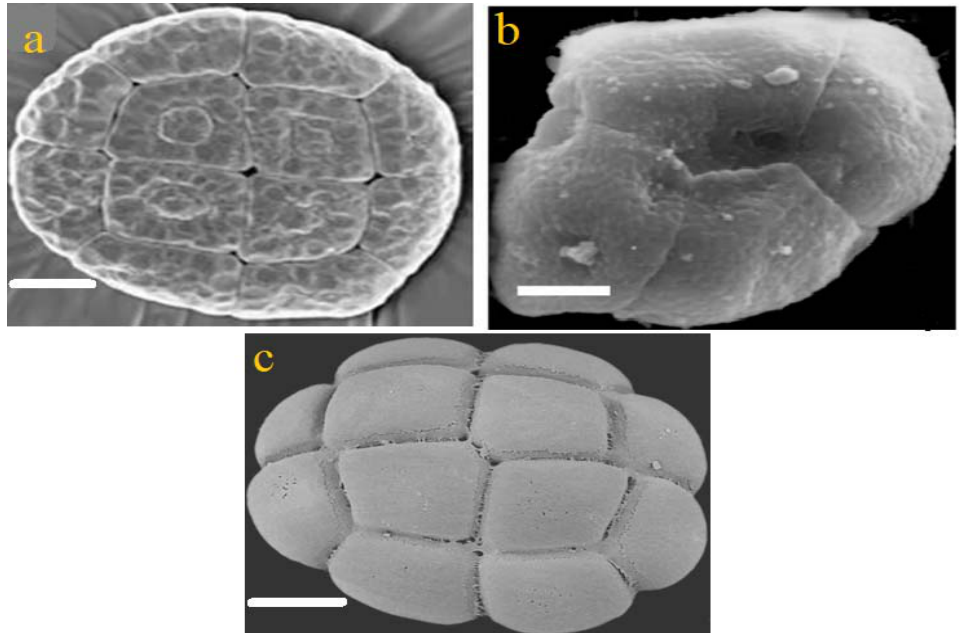
Figure 4. SEM micrographs of the pollen: Acacia mangium ( a ) showing octad polyads; Mimosa bimucronata ( b ) showing bitetrad polyads; Albizia julibrissin ( c ) showing 12-grain polyads. Scale bars: a = 10 µm; b = 2 µm; c = 10 µm.